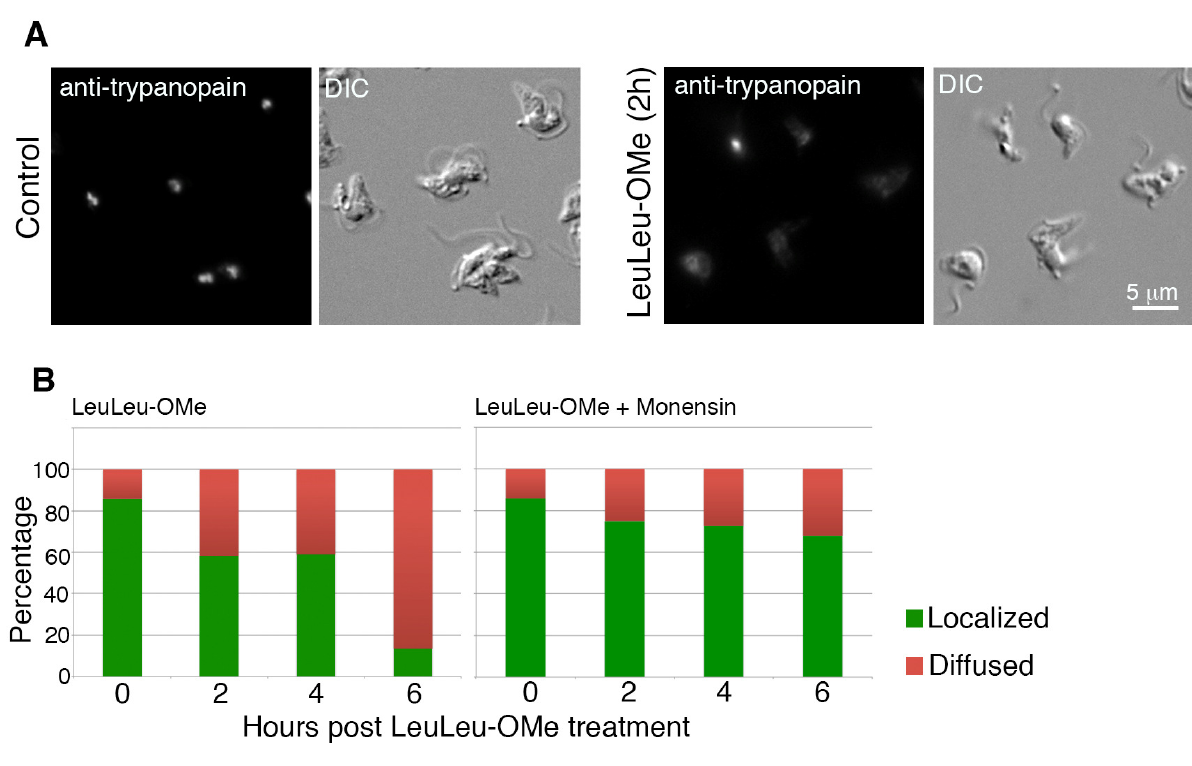
FIGURE 3: LeuLeu-OMe-induced lysosome destabilization revealed by anti-trypanopain staining. (A) Control and LeuLeu-OMe-treated cells were fixed and stained with anti-trypanopain. The staining was localized to one or two puncta in control cells, but became diffused in LeuLeu-OMe-treated cells. Control and drug-treated cells were processed for immunostaining using same conditions. Note that LeuLeu- OMe-treated cells were exposed longer to capture the weaker anti-trypanopain staining in the cytosol. (B) Cells with localized (green) or diffused (red) anti-trypanopain staining were quantitated over the course of LeuLeu-OMe treatment (left), and in cells pre-treated with monensin (right). At least 200 cells were counted for each time